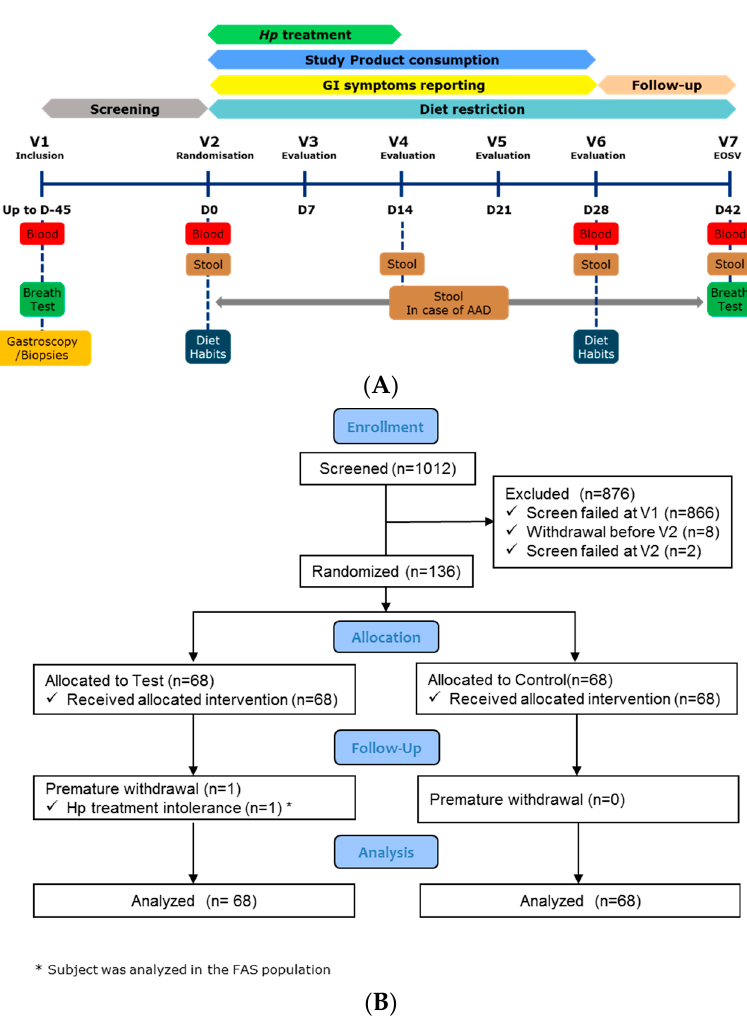
Figure 1. ( A ) Study Design Overview. ( B ) Subject flowchart.